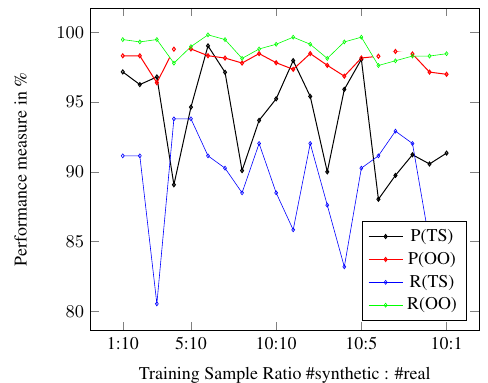
Figure 11. Precision and recall curves for both classes traffic sign (TS) and other objects